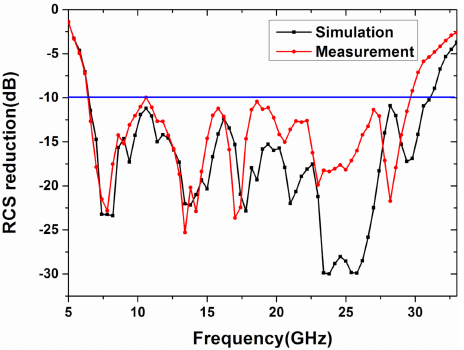
Figure 12. The simulation and measurement of the monostatic RCS reduction, under the x-polarized normal